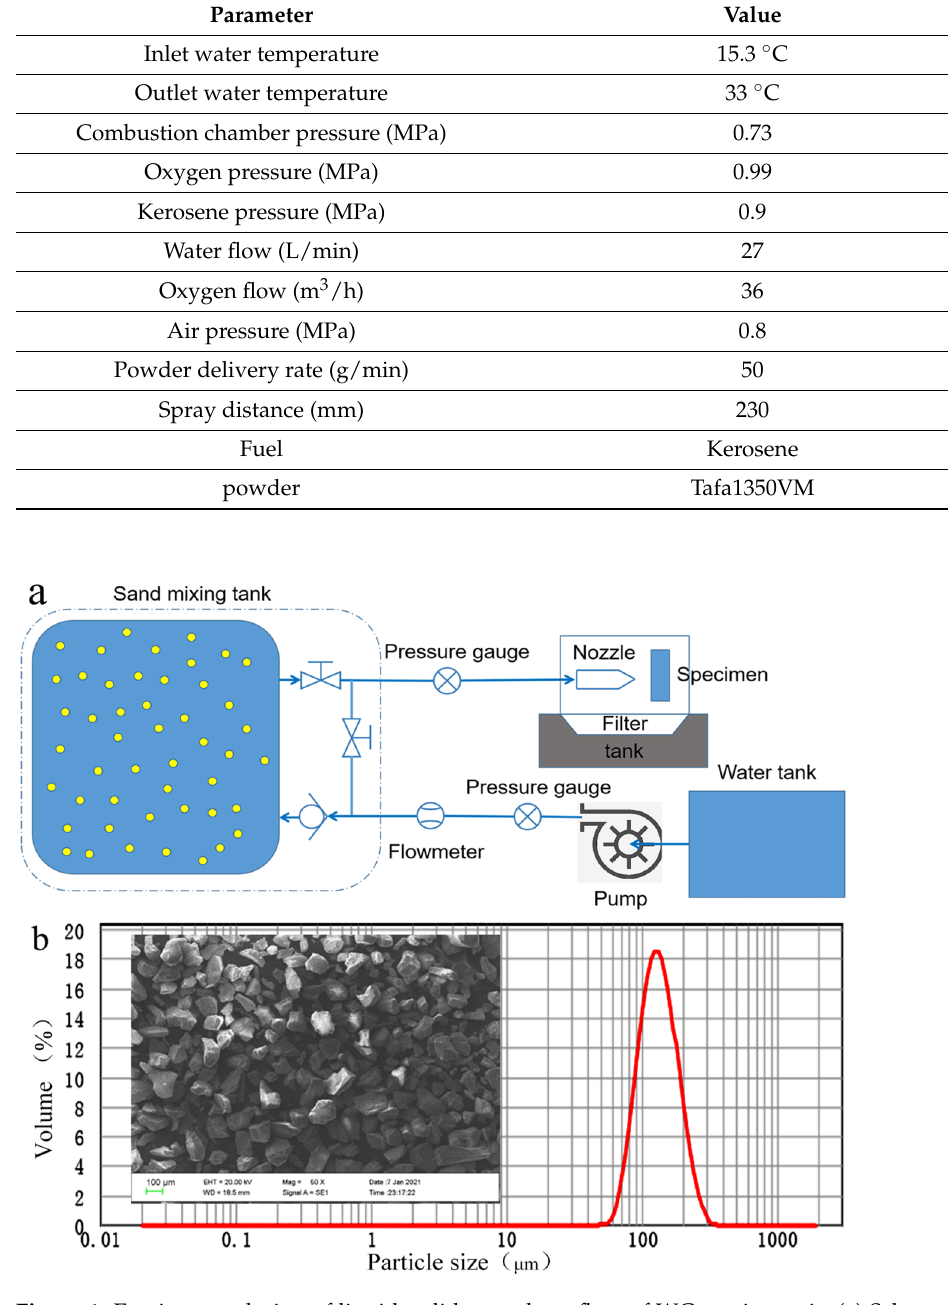
Figure 1. Erosion test design of liquid–solid two-phase flow of WC coating unit. ( a ) Schematic of coupon erosion test. ( b ) SEM micrograph of erosion solid